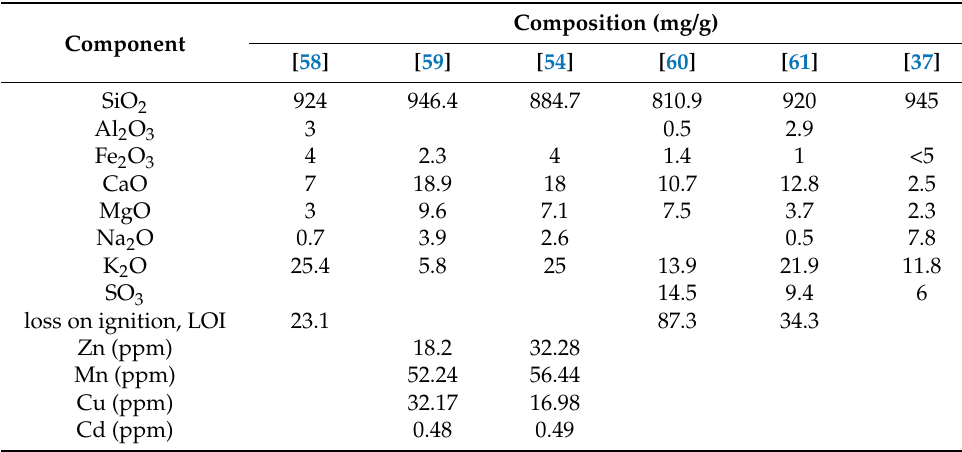
Table 3. Chemical composition of rice husk ash (modified from